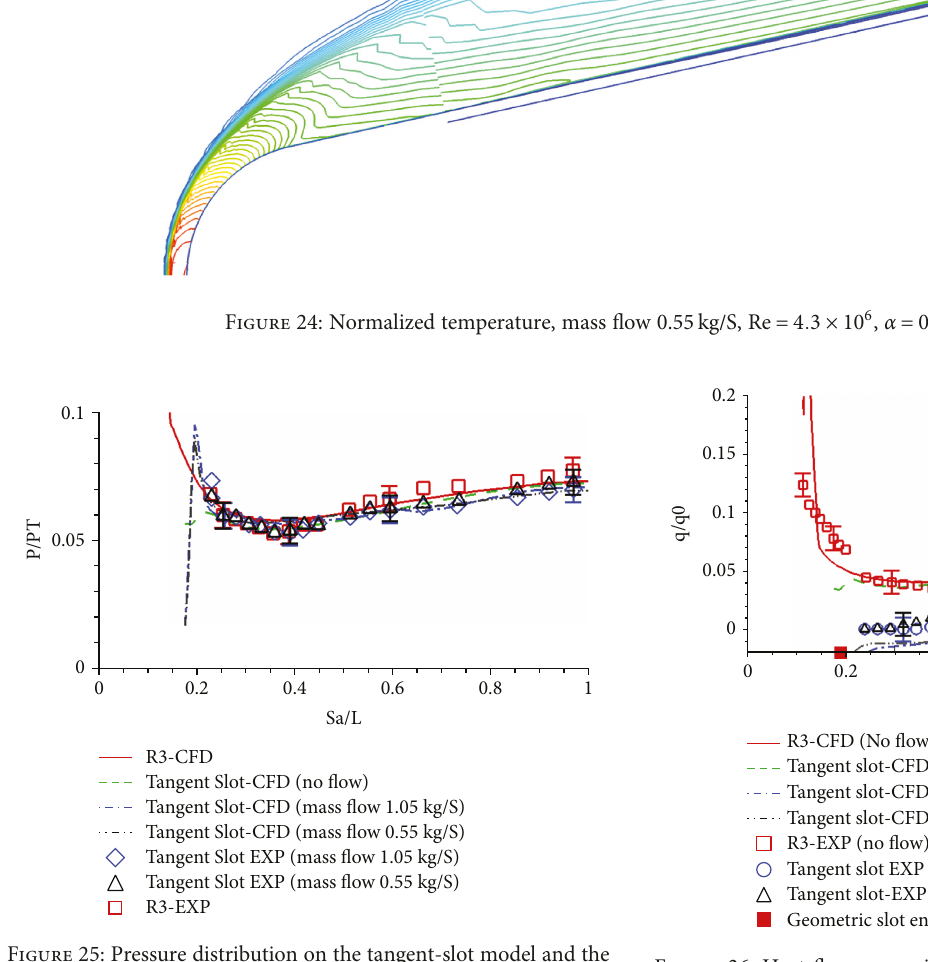
Figure 26: Heat fl ux comparisons on the tangent-slot model and the baseline model, Re = 4 3 × 10 6 , α = 0 0 ° , M = 6